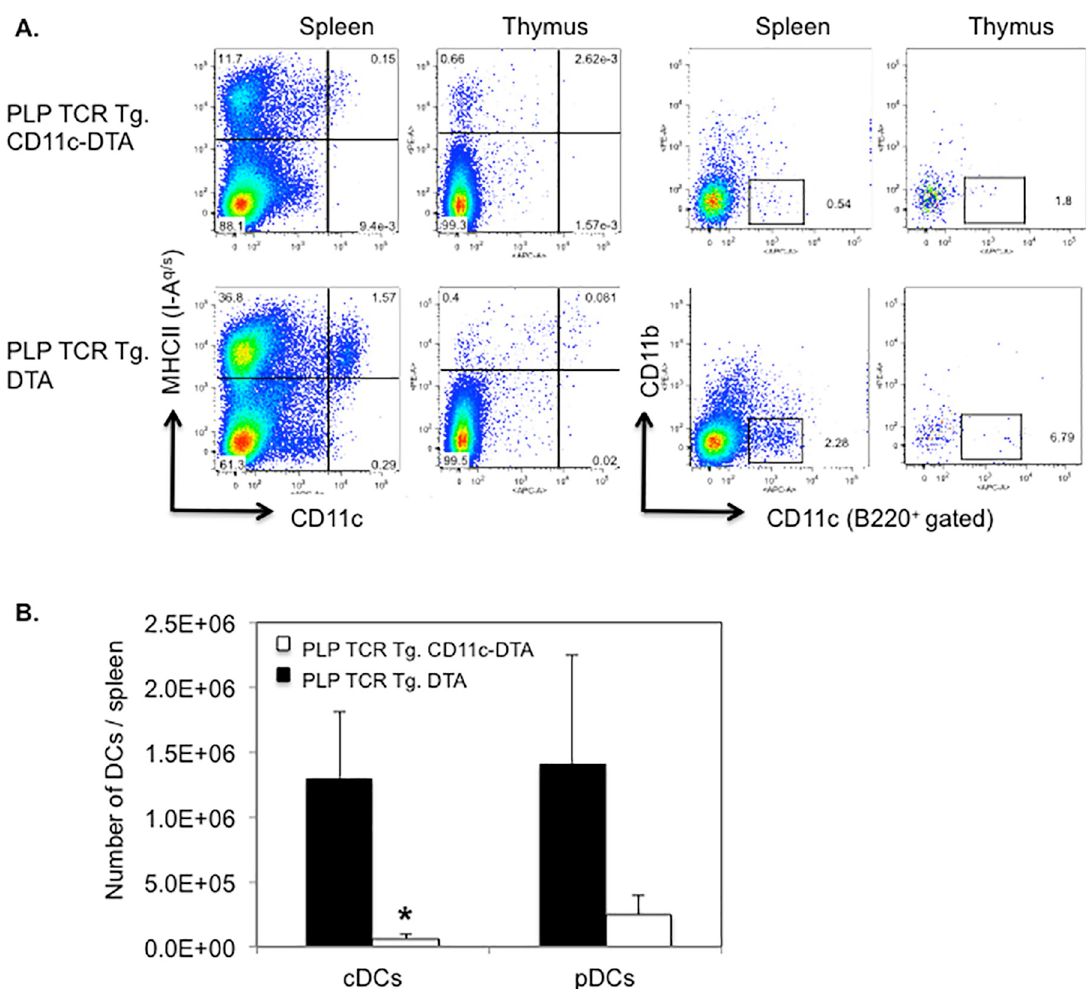
Fig 1. Efficient ablation of DCs in PLP TCR Tg. CD11c-DTA SJL mice. (A) Representative frequencies and (B) mean numbers ± SEM of cDCs (CD11c hi MHC II + ) and pDCs (CD11c lo B220 + CD11b - ) in the thymus (A) and spleen (A, B) of PLP TCR Tg. CD11c-DTA SJL mice (n = 4) or PLP TCR Tg. DTA SJL control mice (n = 3), as determined by flow cytometry, are shown. Numbers in dot plots represent percentages of live cells. Data shown are from four independent experiments. � p = 0.03 (Student’s t